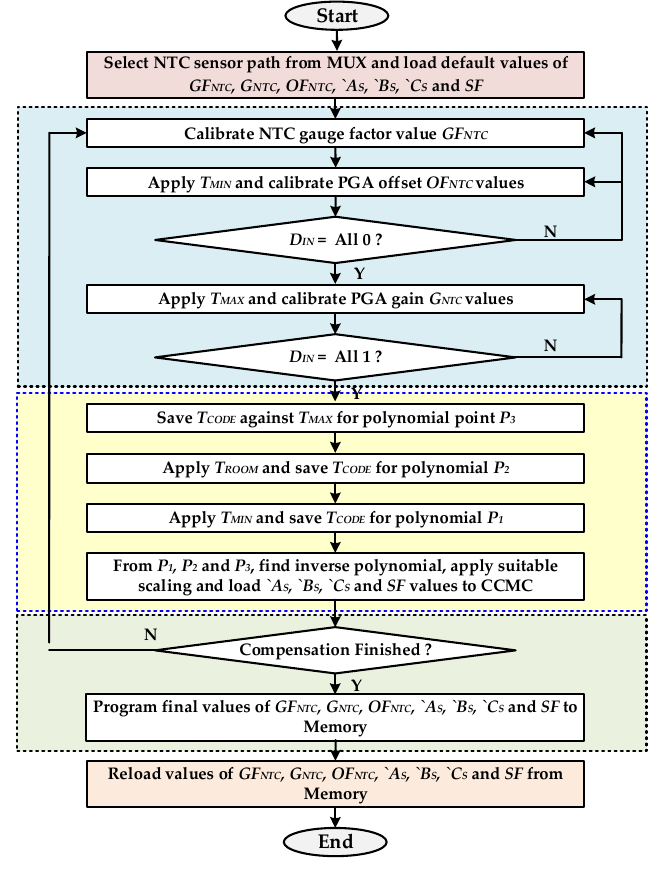
Figure 4. Temperature compensation parameter preparation flow chart.